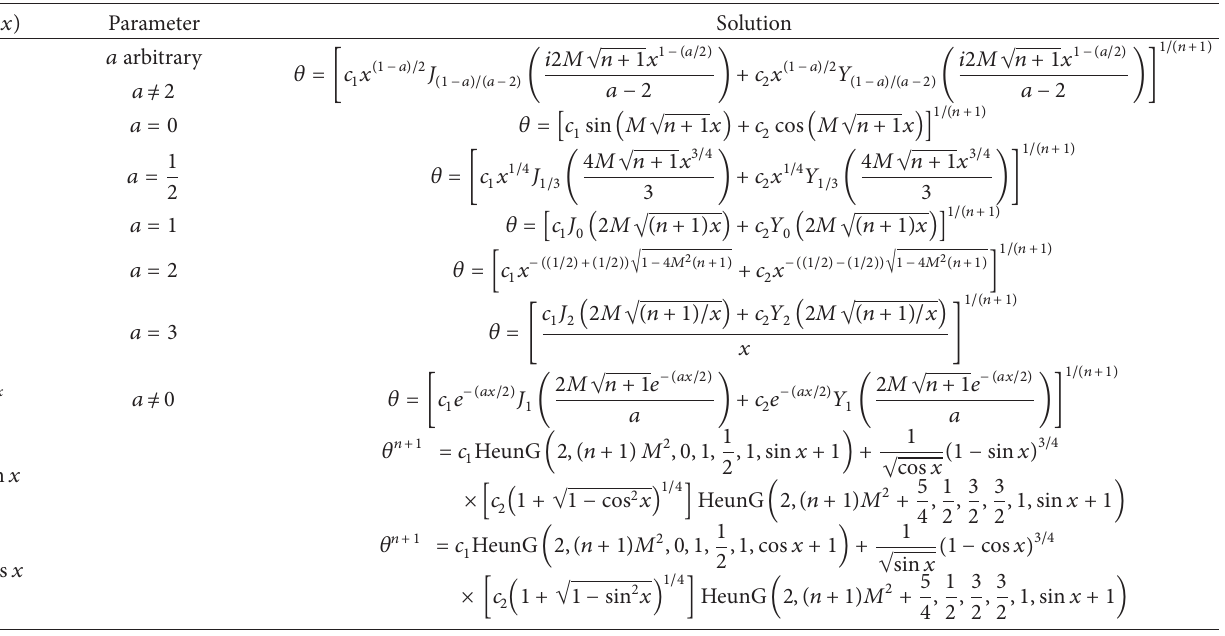
Table 3: Solution for 𝑛 < −1 with 𝑚 = 𝑛 ̸= − 1 .